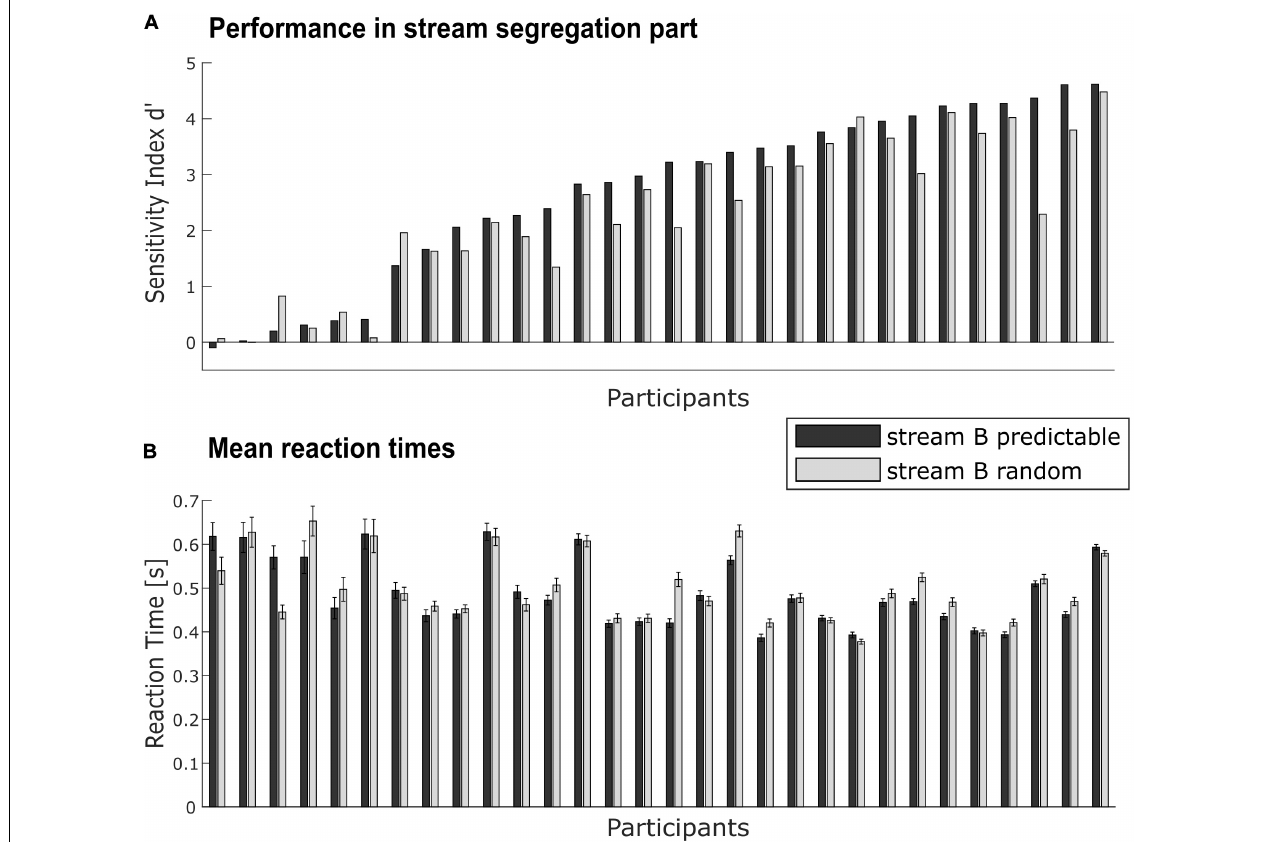
FIGURE 3 | Individual performance in the target detection task. (A) Performance for each participant ( N = 30) as measured by sensitivity d’ for predictable (black bars) and random conditions (gray bars). (B) Mean reaction times to detected targets in the task-relevant stream for each participant in both conditions (notation as in A ). Error bars indicate the standard error in each condition within the participant. Data in both panels is sorted by performance in the predictable condition.